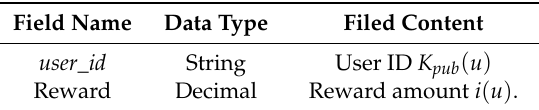
Table 3. Schema of user database.